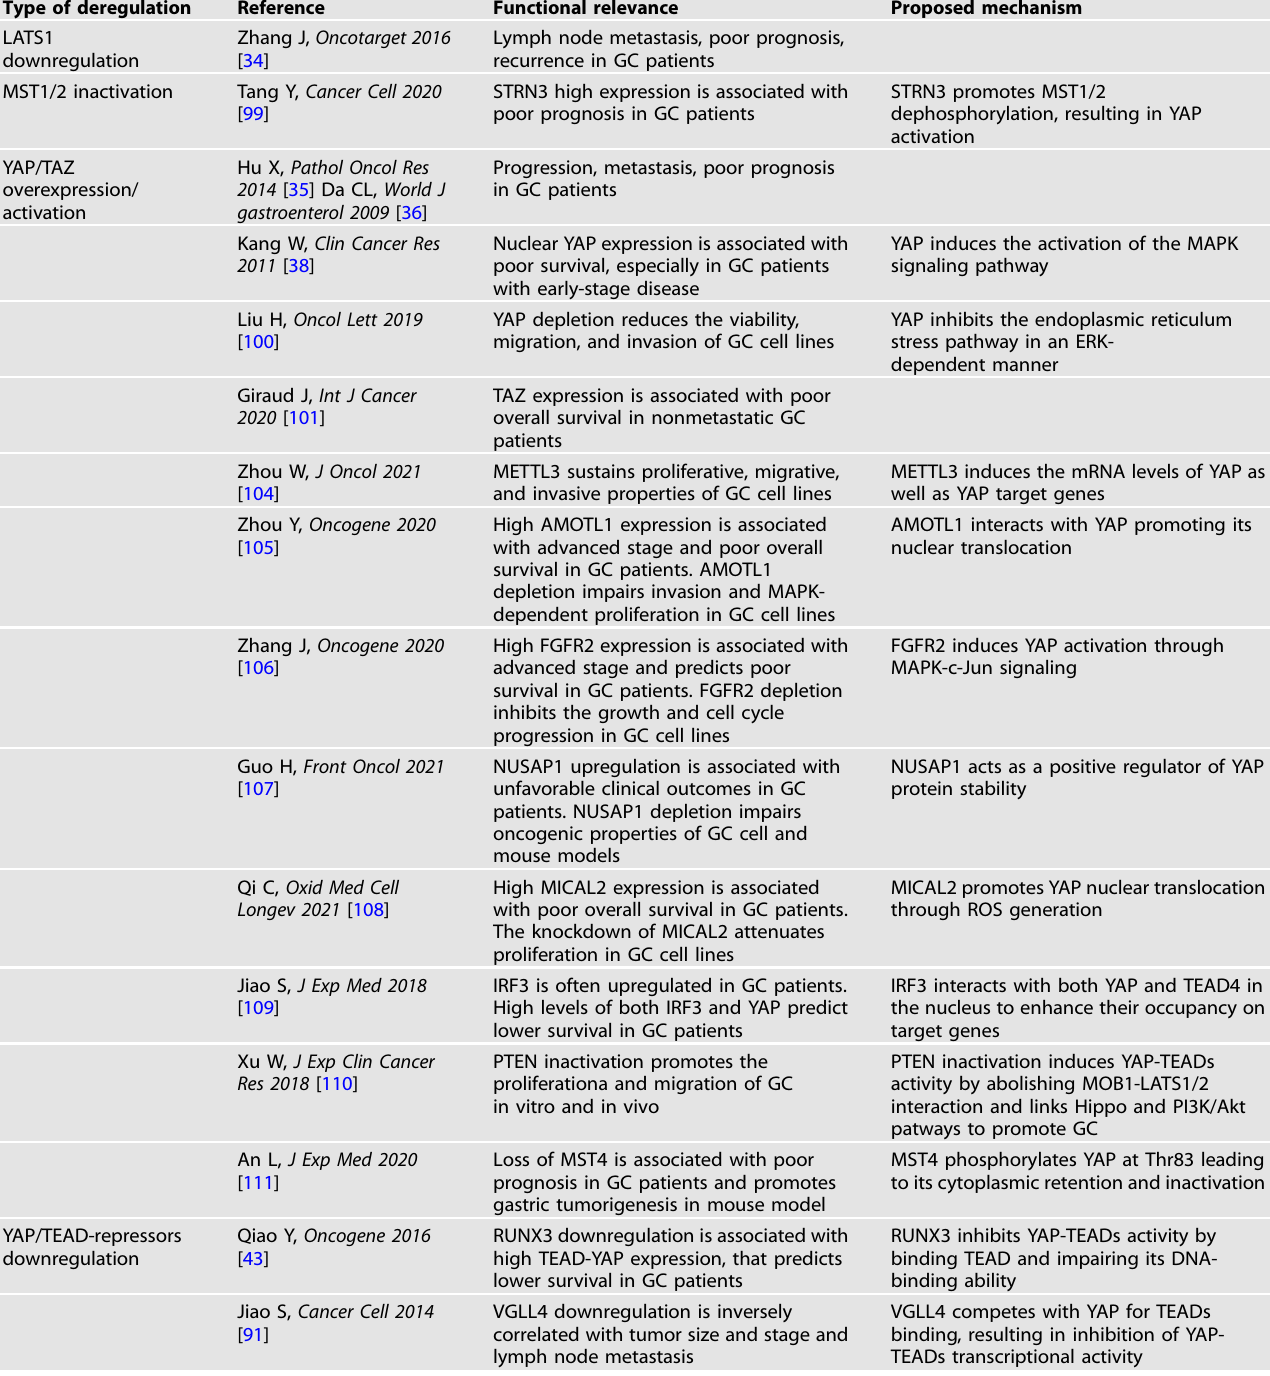
Table 1. Hippo pathway deregulation events reported in gastric